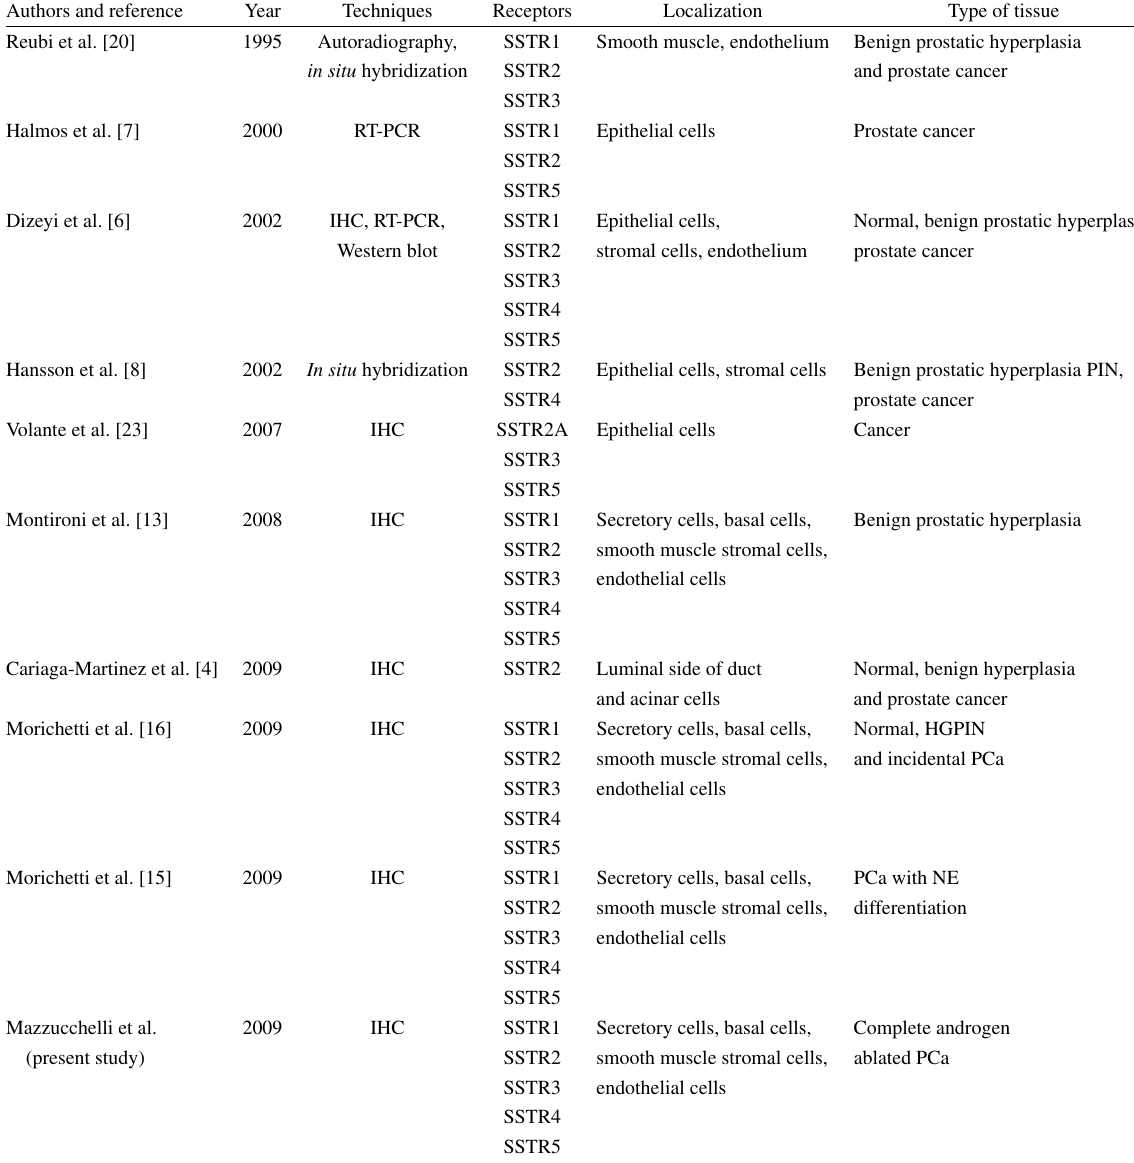
Studies on the expression and localization of the SSTRs in human prostate